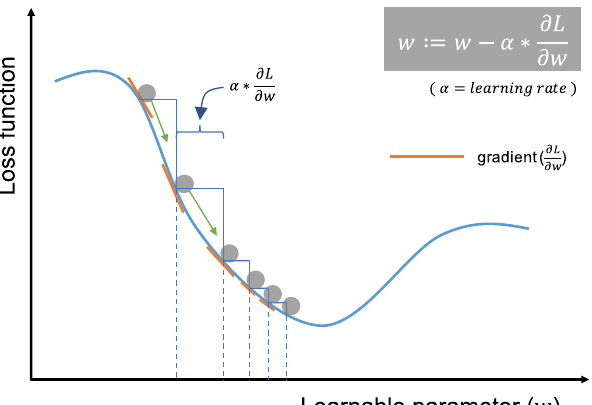
Fig. 7 Gradient descent is an optimization algorithm that iteratively updates the learnable parameters so as to minimize the loss, which measures the distance between an output prediction and a ground truth label. The gradient of the loss function provides the direction in which the functionhasthe steepestrateofincrease, andall parametersare updated in the negative direction of the gradient with a step size determined based on a learning